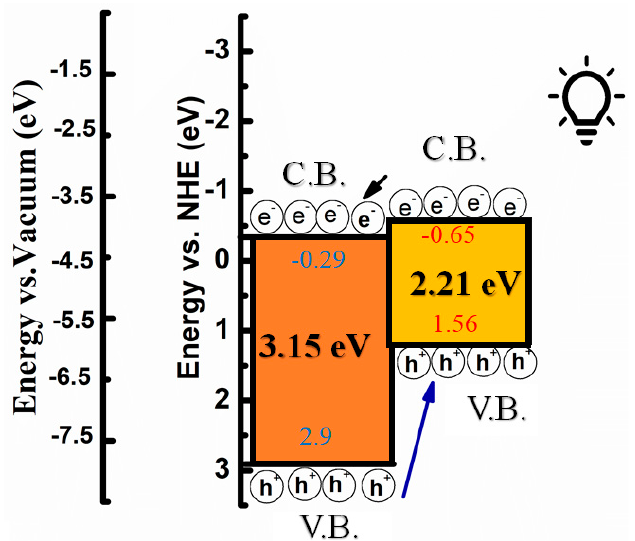
Figure 10. Schematic band alignment of optimal structure of Ag 2 S/ZnO NRs with concentrations of 0.005 M of AgNO 3 and 0.03 M of CS(NH 2 ) 2 .